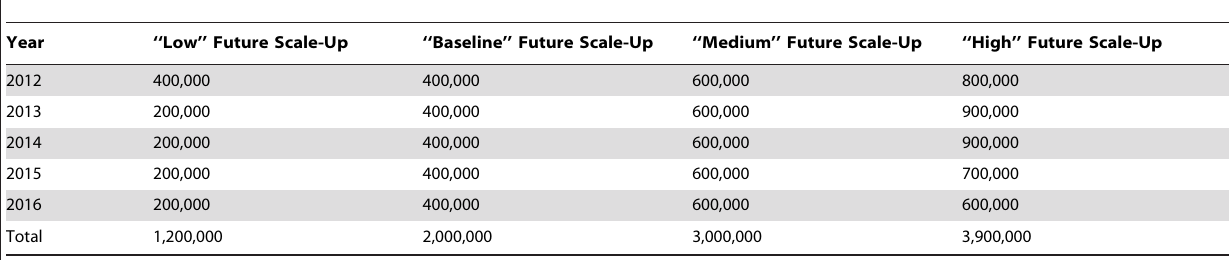
Table 2. Number of adults starting ART each year in the short